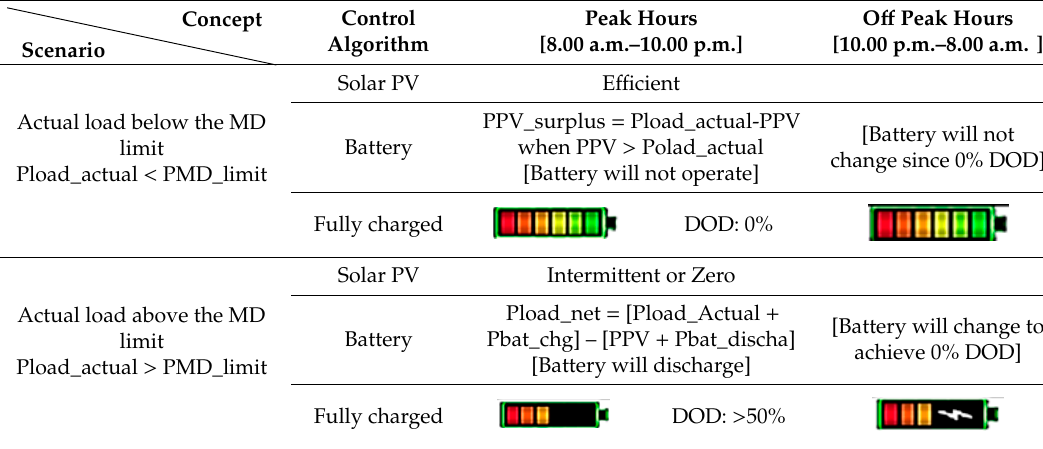
Table 7. Battery Energy management system for MDRed modeling approach.